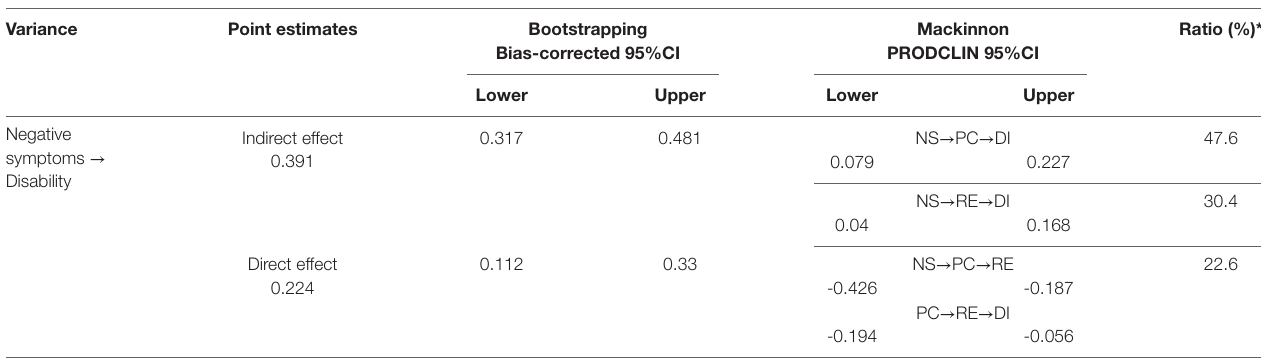
TABLE 4 | Results of bootstrap and PRODCLIN